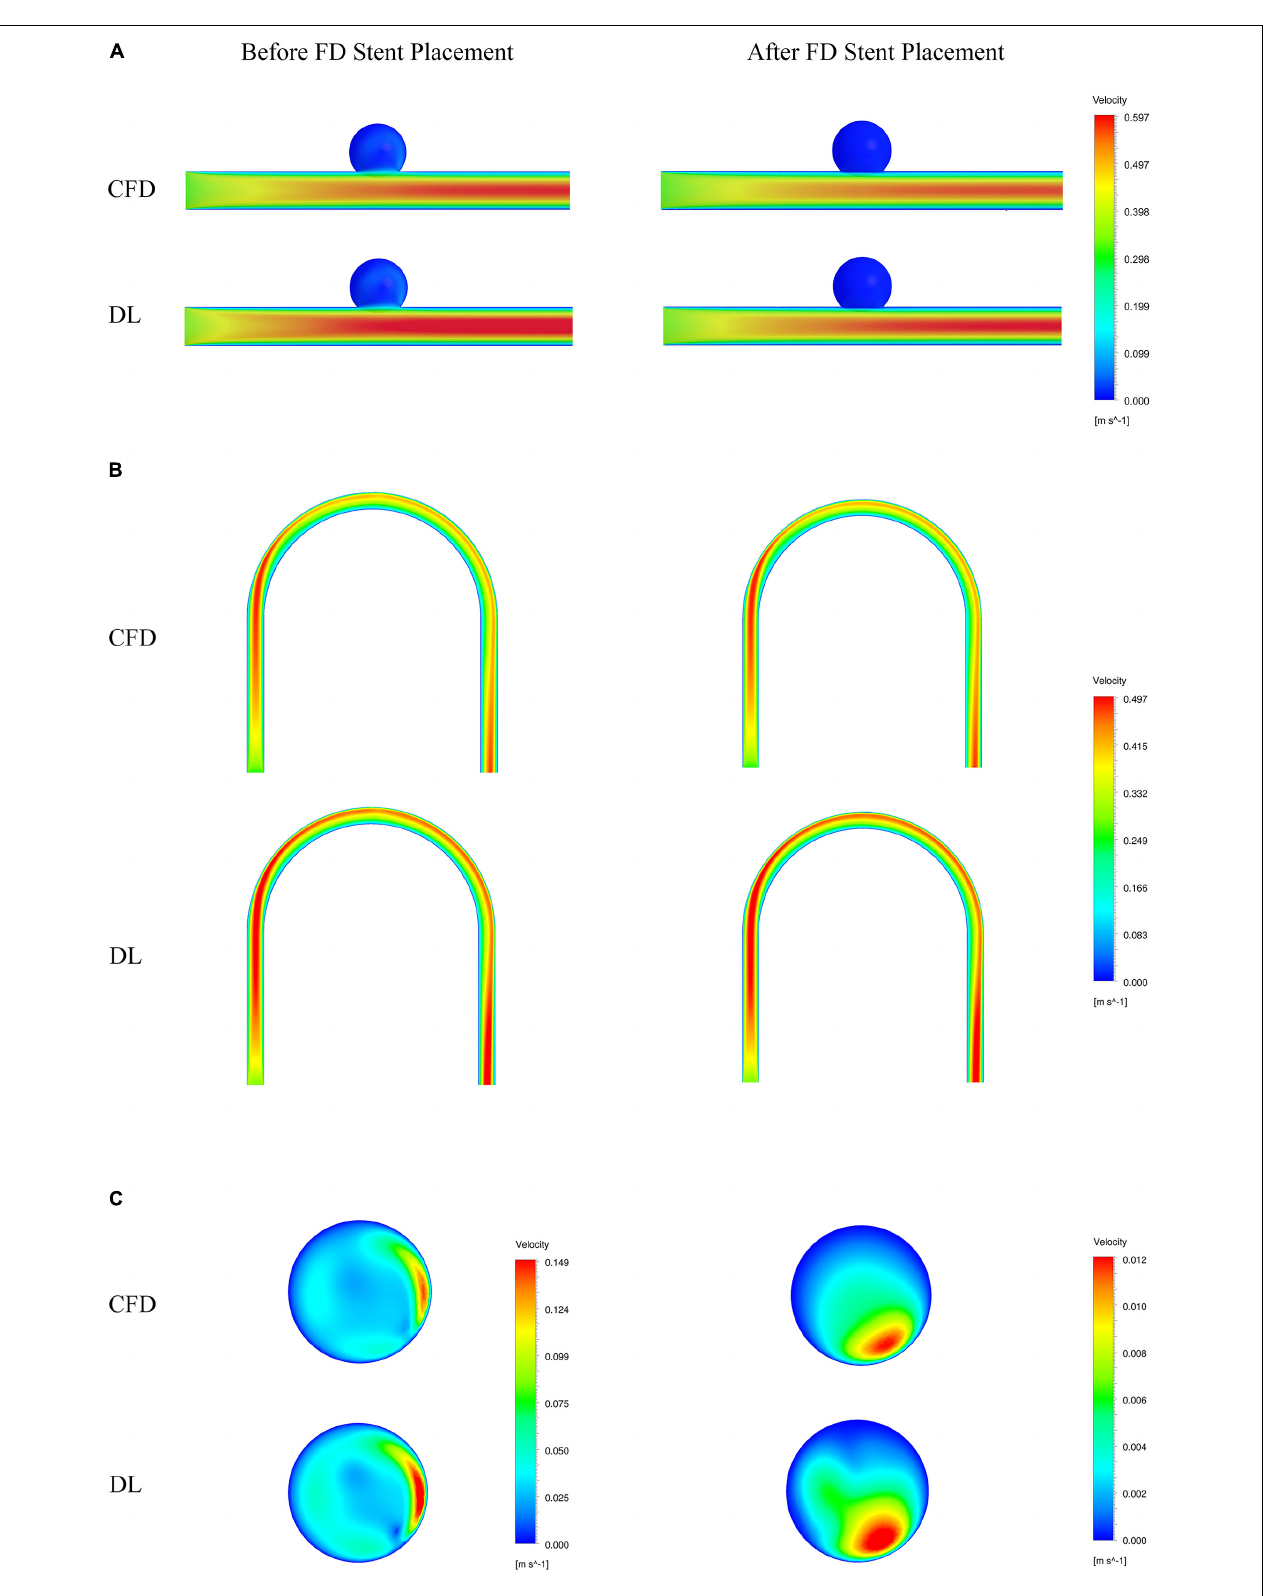
FIGURE 5 | Comparison of velocity fields from CFD and deep learning (DL) methods. (A) Type 1 model symmetry plane. (B) Type 2 model parent artery symmetry plane. (C) Type 2 model aneurysm cross section.